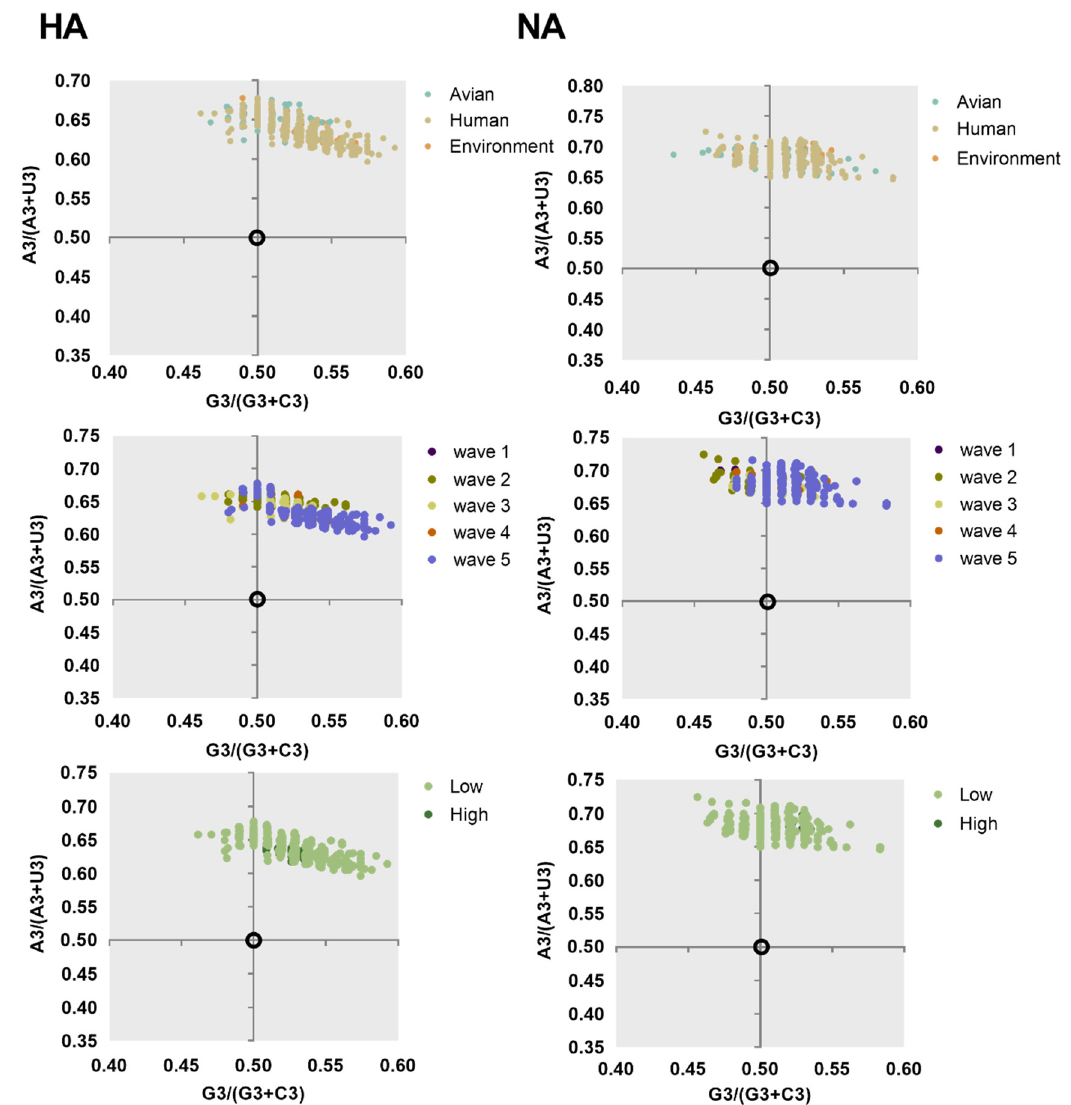
Figure 5. Parity Rule 2 (PR2) analysis of HA and NA of different classification. Far away from the origin indicates that there is a bias between the effect of mutation pressure and natural selection.